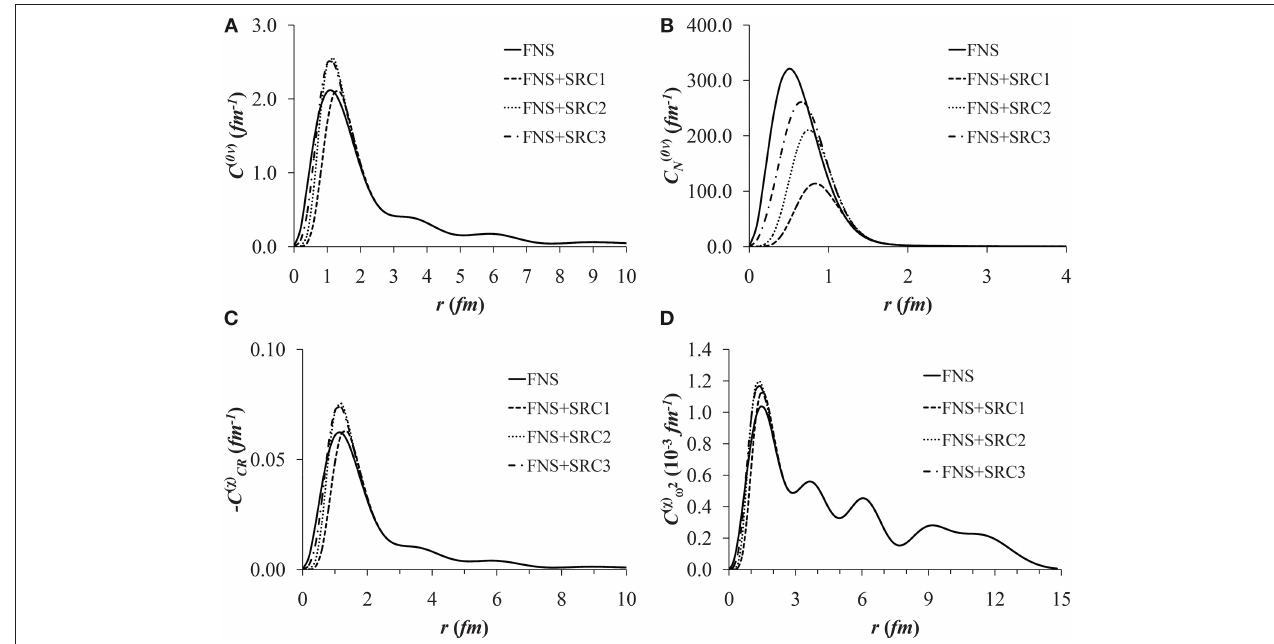
FIGURE 1 | Radial dependence of (A) C (0 ν ) ( r ), (B) C (0 ν ) N ( r ), (C) C ( χ ) CR ( r ), and (D) C ( χ )